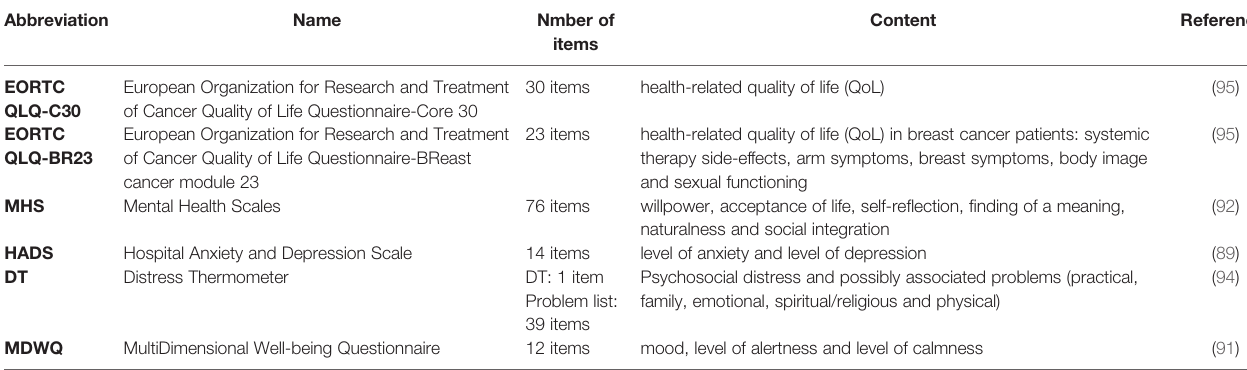
TABLE 8 | Assessment of the psychological parameters (used